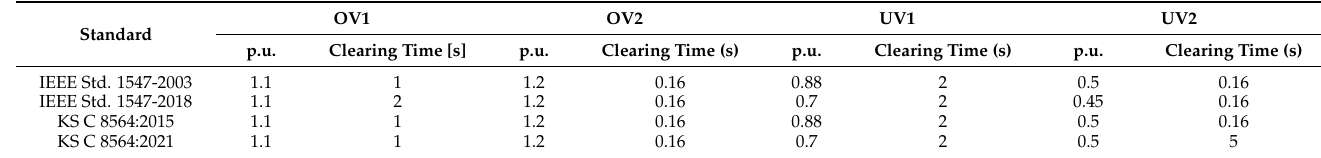
Table 1. DG response to abnormal voltage by the standards.